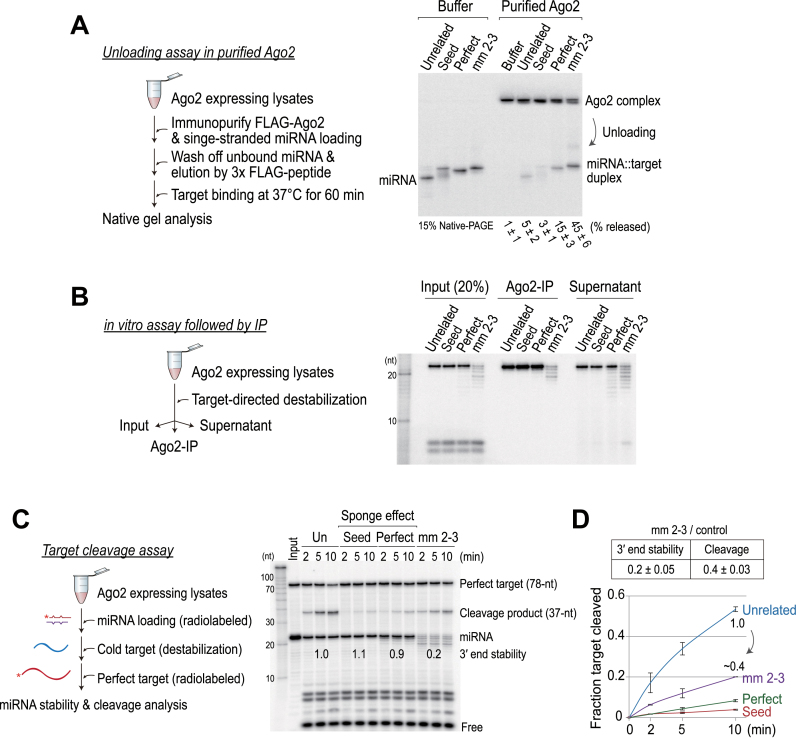
The target-directed mechanism entails a combination of unloading and 3΄ end destabilization in Ago protein. (A) Left: schematic of the experiment. Right: large fractions of miRNAs were in Ago2-complexes after non-canonical target binding. In the buffer control, single-stranded miRNAs were annealed to each target RNA at 37°C. (B) Left: schematic of the experiment. Right: 3΄ end destabilization occurs in Ago2-bound fraction during non-canonical target binding. (C) Left: schematic of the experiment. Right: a substantial fraction of 3΄ trimmed miRNA species in the Ago2-complex can participate in cleavage catalysis. (D) Top: miRNAs that are destabilized by non-canonical targets (0.2 ± 0.05) are capable of catalyzing cleavages, whose efficiencies are higher than expected (0.4 ± 0.03). Discrepancies between the two results (3΄ end stability and target cleavage) indicate that many miRNAs are still in Ago2–RISC following target-directed destabilization. Bottom: quantitation of the fraction target cleaved is shown. Data are the mean ± SD for two independent experiments.